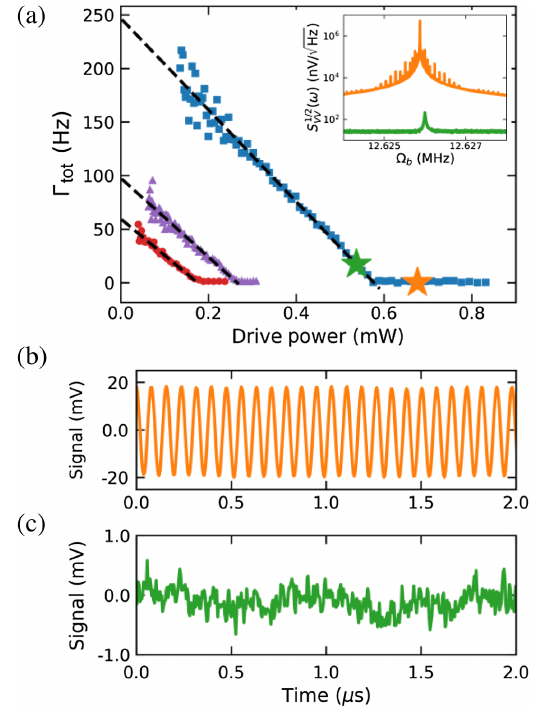
FIG. 5. Parametric instability. (a) Mechanical linewidth as a functionofdrivepowerinair(bluesquares),heliumpartialpressure ∼ 15 mTorr (purple triangles), and vacuum (red circles). The single magnon-phonon coupling rate extracted from these curves = 2 π ¼ 4 . 65 , 4.66, 4.43 mHz, respectively. For these data was g 0 mb the normal mode spectrum was tuned to Fig. 2(d), and the probe tone was tuned on resonance with the magnonlike mode. Inset: Power spectral density of the mechanical motion for the green (drive power ¼ 0 . 54 mW) and orange (drive power ¼ 0 . 68 mW) markers, respectively. (b) Phase coherent oscillations are visible withinthetime-domainsignal;here,thedrivepowerissetabovethe parametric instability threshold. (c) With the drive power set below the parametric instability threshold, the time-domain signal is comprised primarily of phase-incoherent mechanical noise.